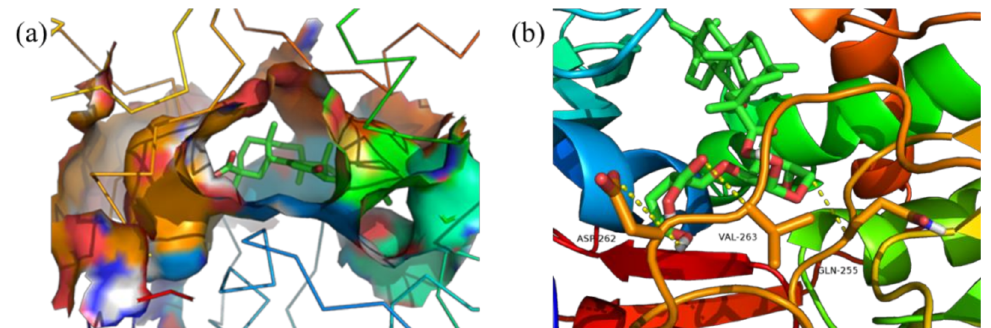
Figure 11. Docking conformation diagram ( a ) and hydrogen bonding diagram ( b ) of GA-BX/AD-g-IA with 2W4Q.